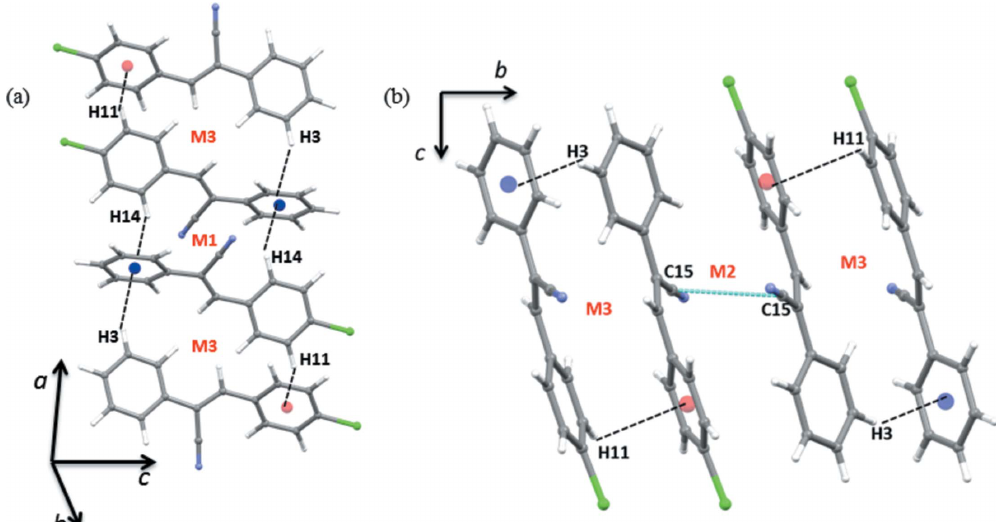
Figure 4 ( a ) The molecular chain generated by intermolecular C—H (cid:2)(cid:2)(cid:2) (cid:2) interactions (motif sequence M3 (cid:2)(cid:2)(cid:2) M1 (cid:2)(cid:2)(cid:2) M3) and ( b ) adjacent M3 motifs interlinked by nitrile–nitrile stacking (motif M2). The centroids are shown as small spheres ( Cg 1 blue and Cg 2 red).